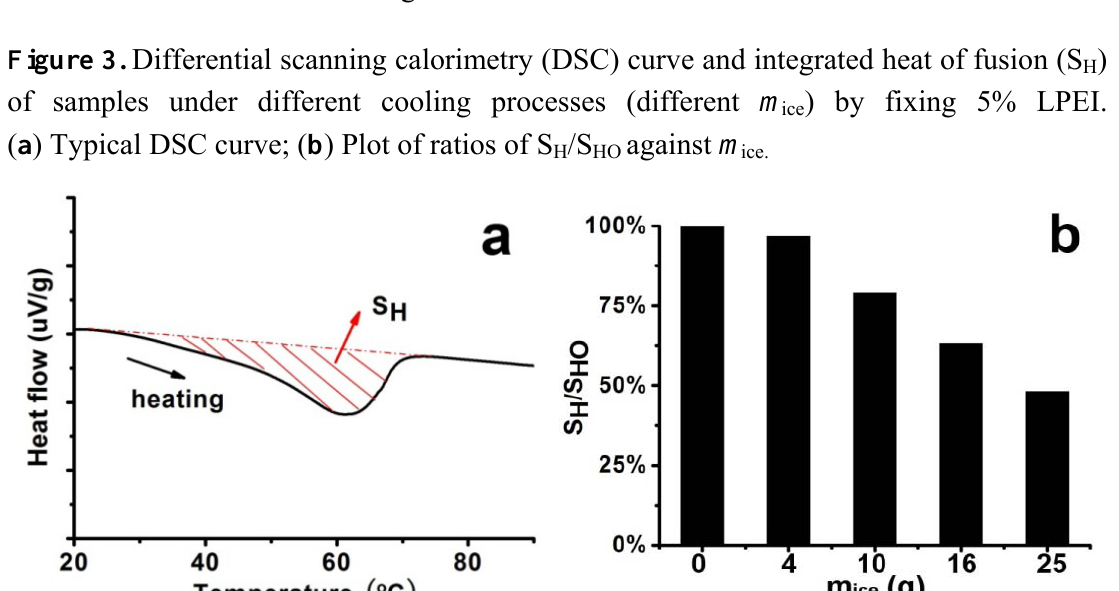
Figure 3. Differential scanning calorimetry (DSC) curve and integrated heat of fusion (S of samples under different cooling processes (different m